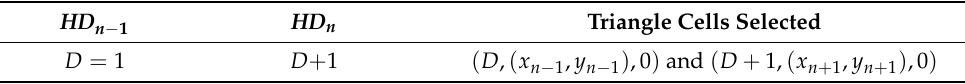
Table 22. HtoTcode rule of the ( n − 1)th hexagon cell C 1 and the n th hexagon cell E 2